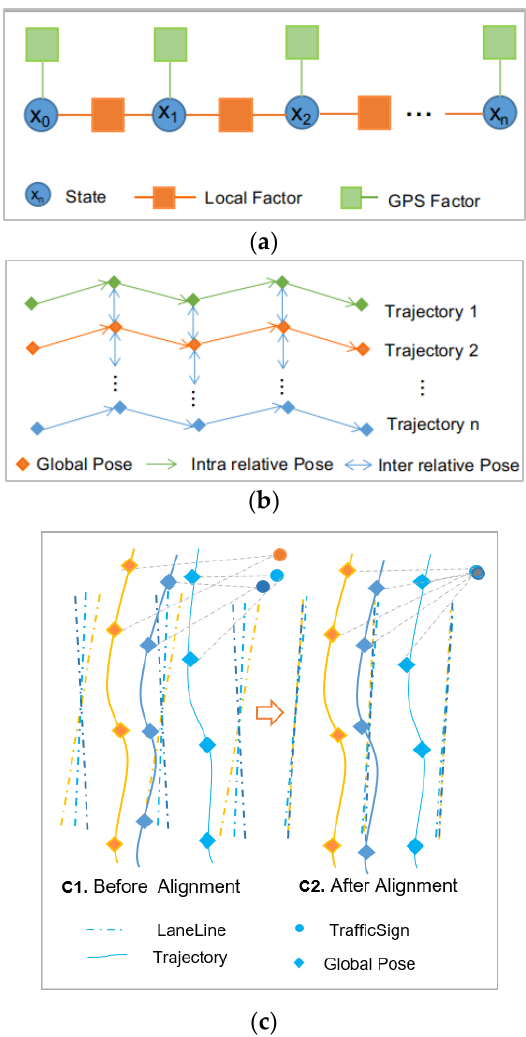
Figure 5. The structure of the fusion mapping on-cloud algorithm. ( a ) Global pose graph optimization; ( b ) semantic alignment; ( c ) semantic aggregation. Different color line represents different trajectory.